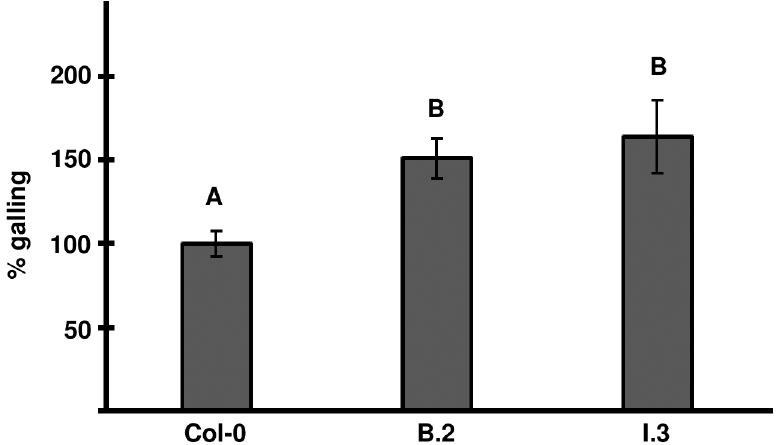
Fig 5. Transgenic Arabidopsis expressing MiPFN3 are more susceptible to M . incognita . Two week old seedlings grown on MS media were inoculated with 100–150 M . incognita J2 and galling was quantified at 4 weeks post- infection. The relative number of galls in the transgenic lines B.2 and I.3 was higher than in the control Col-0. The average number of galls per plant in Col-0 was set 100%. Values are the means of at least 3 independent experiments +/- sem. (Col-0, n = 176; B-2, n = 161; I.3, n = 61). Different letters indicate significance using the Games-Howell Method and 95% Confidence.